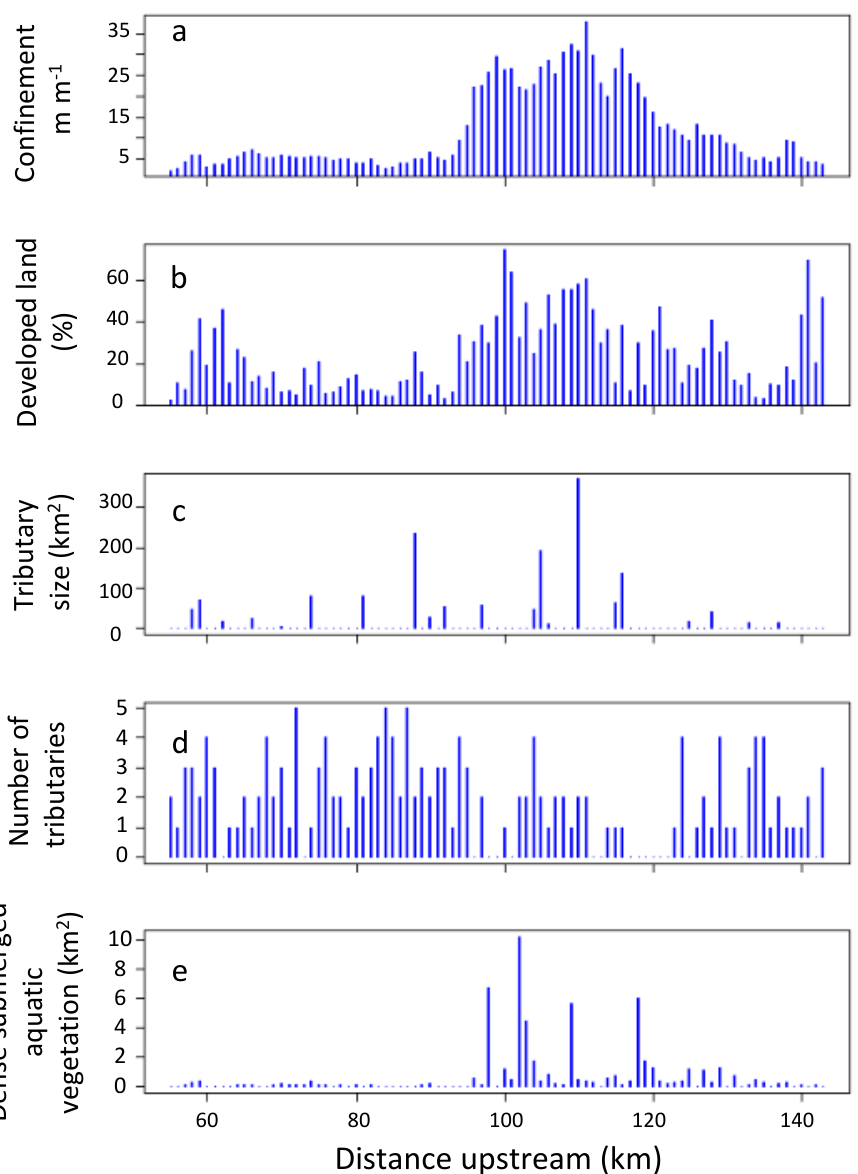
Figure 7. Longitudinal profiles of landscape metrics in the Pend Oreille River: Confinement ( a ), developed land ( b ), contributing tributary size ( c ), number of tributaries ( d ), and dense submerged aquatic vegetation ( e ). Bin width is 1